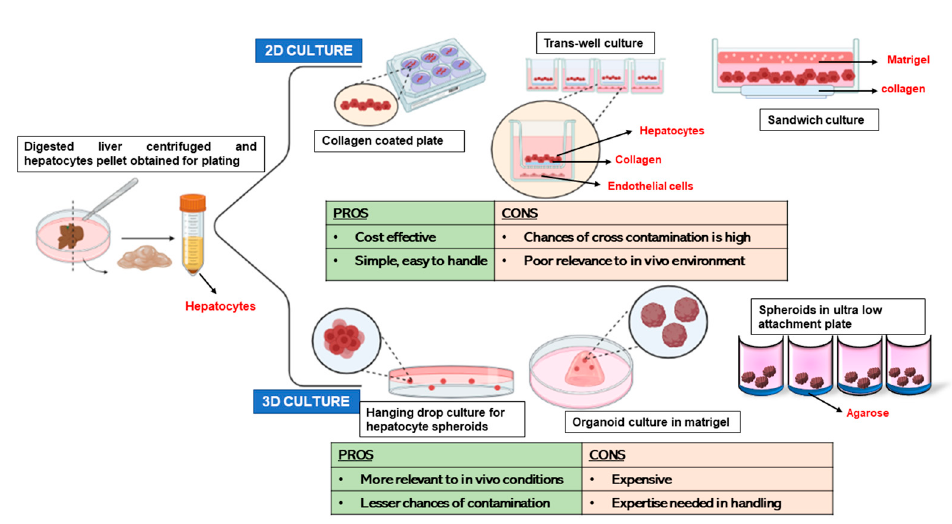
Figure 2. Various methods of 2D and 3D culture of hepatocytes. 2D methods include conventional collagen ‐ coated plates, trans ‐ well and sandwich culture and 3D culture methods include hanging drop culture, organoid culture and spheroid culture. Advantages and disadvantages of each method provided. Original images by authors created with Biorender.com